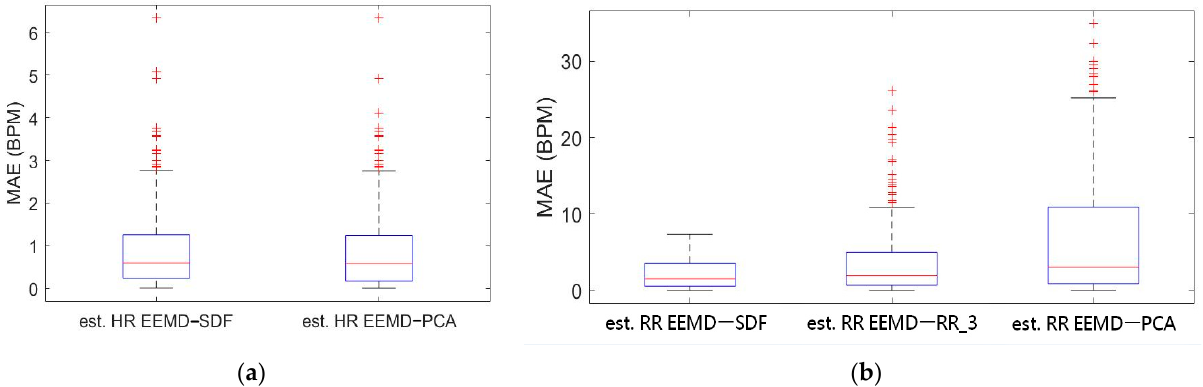
Figure 5. ( a ) Boxplot of MAE bias of the estimated HR using EEMD-SDF and EEMD-PCA; ( b ) boxplot of MAE of the estimated RR using EEMD with SDF, RR_3, and PCA.